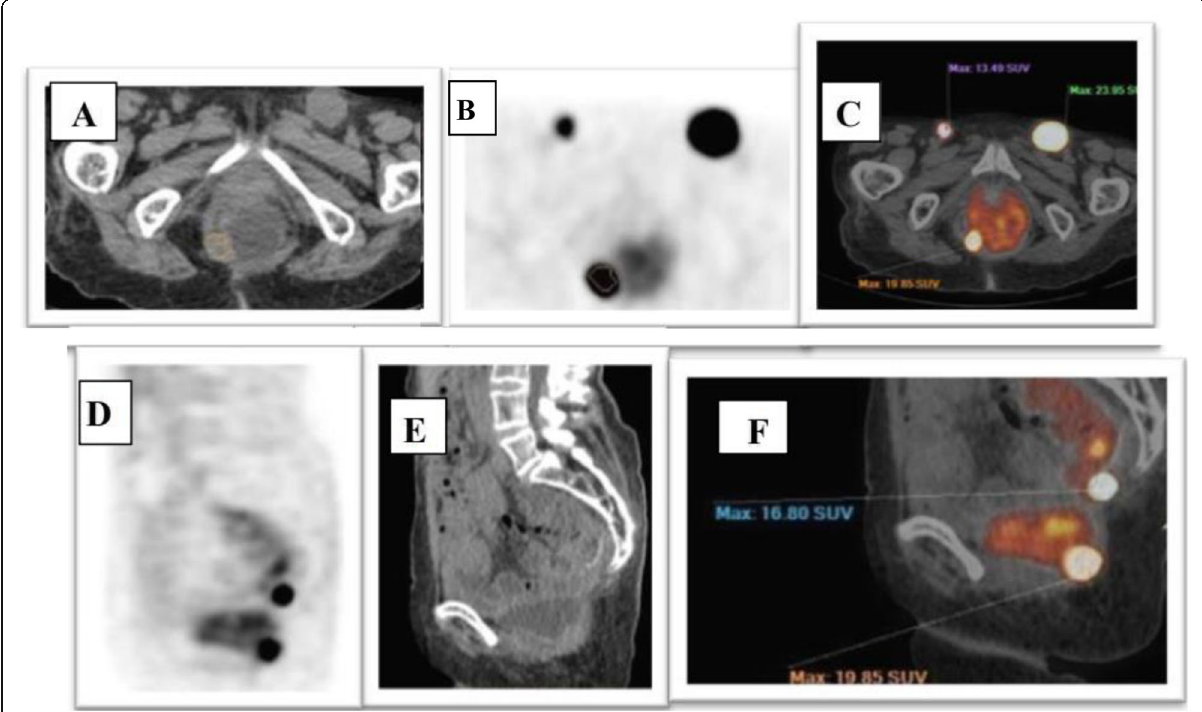
Fig. 1 A 66-year-old female patient with a history of rectal carcinoma received chemo-irradiation followed by surgical resection, presented by elevated CEA. Her PET/CT assessment shows a axial CT, b axial PET, d sagittal PET, c axial PET/CT, f sagittal PET/CT PET CT showing the following: heterogeneous hypermetabolic soft tissue nodule at the operative bed (along the right basal aspect of mesorectal fascia) measuring 19 × 10 mm achieving 19.8 SUV max ( a , b , f ); another smaller intensely avid one measuring 14 × 10 mm is seen opposite the tip of coccyx achieving 16.8 SUV max ( f ); and bilateral enlarged hypermetabolic inguinal lymph nodes achieving 23 and 13 SUV max ( c